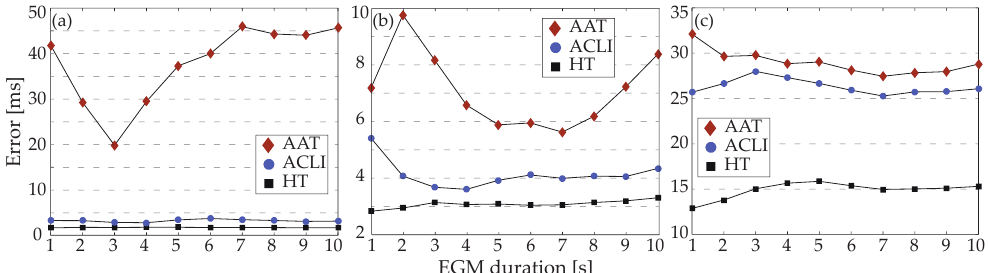
Figure 6. Individual CL error depending on EGM length for the three LAW detection methods analyzed: ( a ) Results for type I electrograms; ( b ) type II electrograms; and ( c ) type III